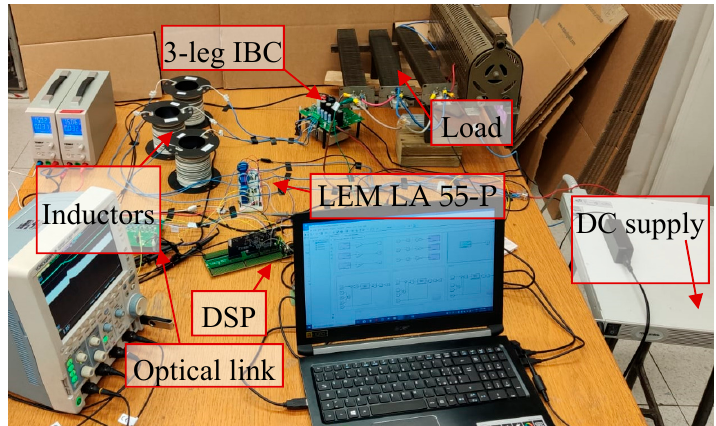
Figure 17. Experimental setup.